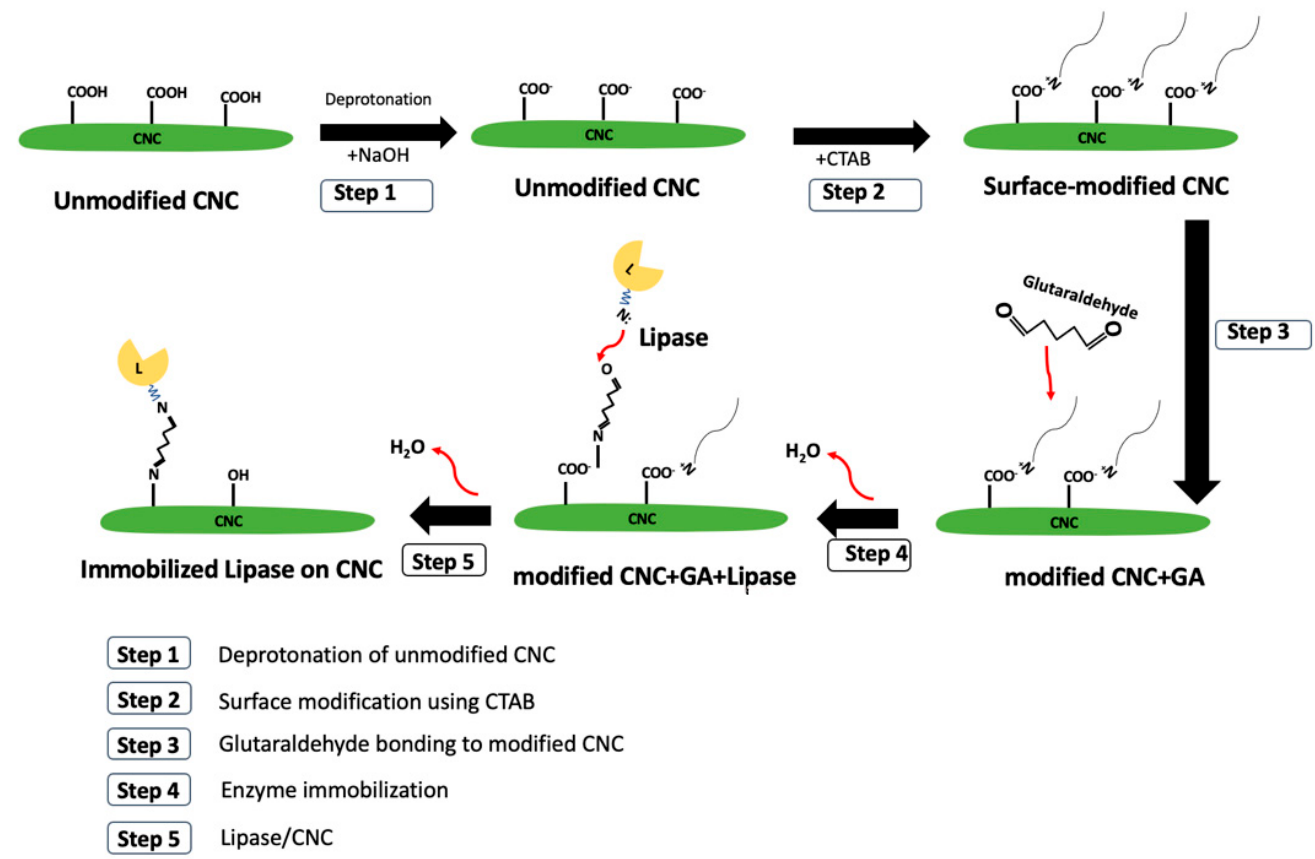
Figure 11. Scheme of the immobilized lipase onto the modified CNC.